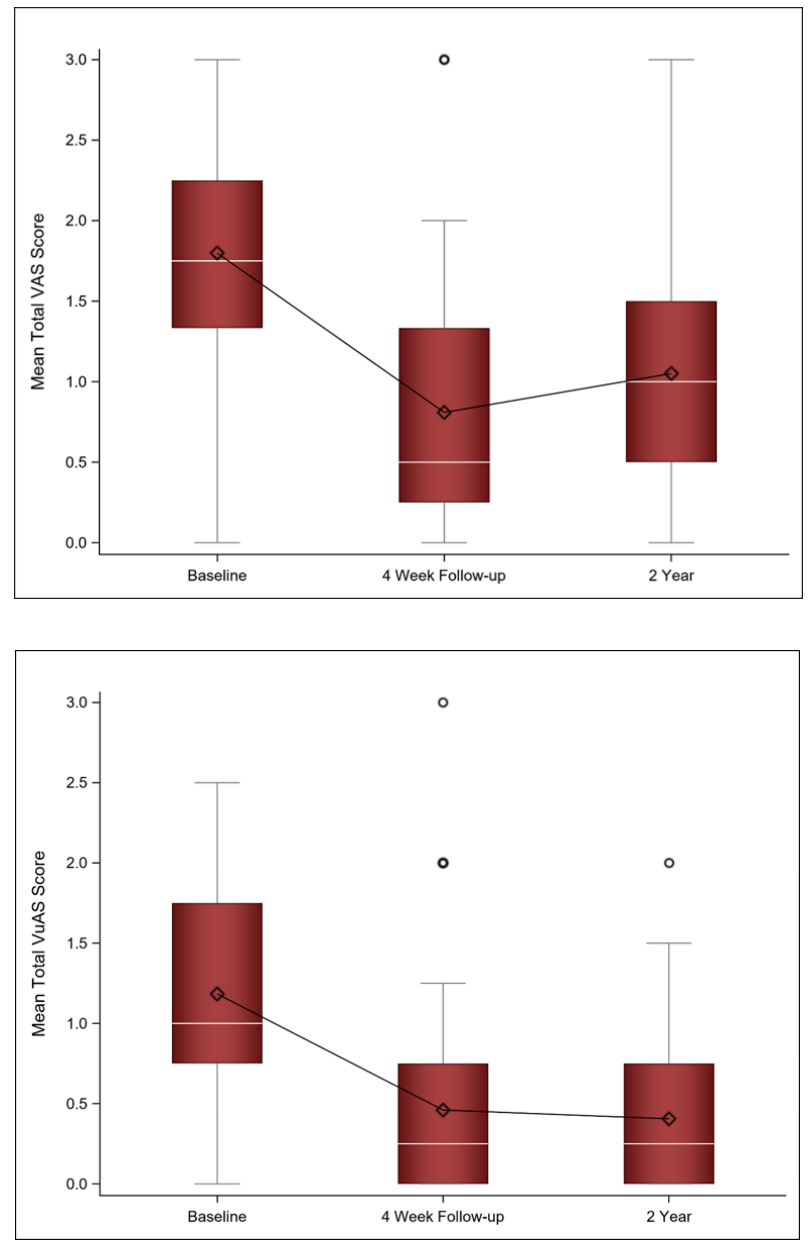
Figure 2. Mean (diamond), median (white line), and the 1st and 3rd quartiles are displayed for the VAS and VuAS at baseline, 4 week, and 2 year follow-up. The whiskers are the distance equal to 1.5 times the interquartile range (IQR). The diagram also shows outliers (circles) which are values that above or below the whisker ends. VAS = Vaginal Assessment Scale; VuAS = Vulvar Assessment Scale